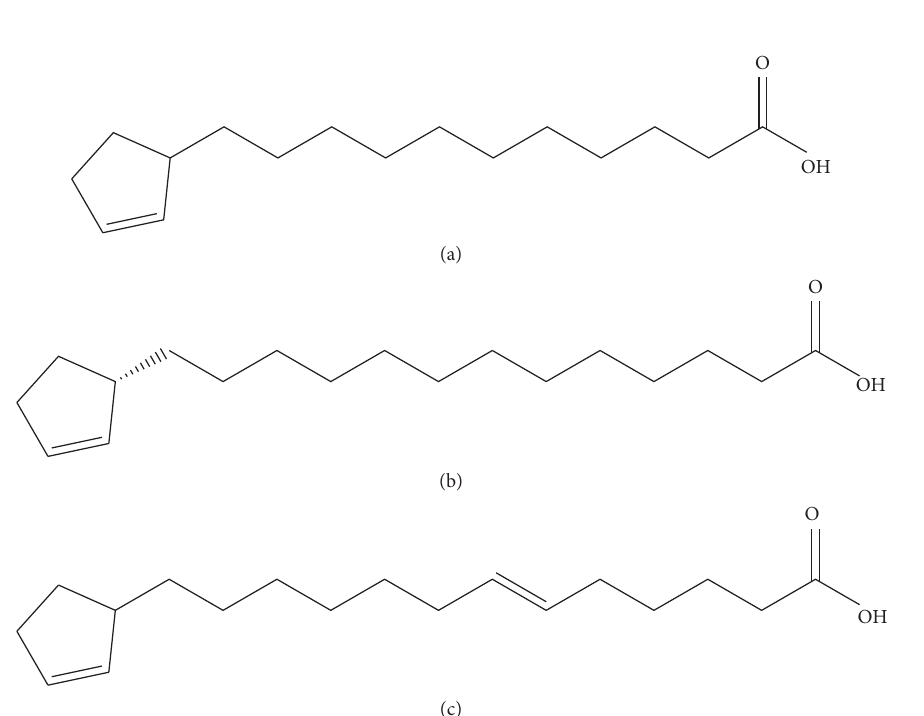
Figure 3: Structure of (a) hydnocarpic acid, (b) chaulmoogric acid, and (c) gorlic